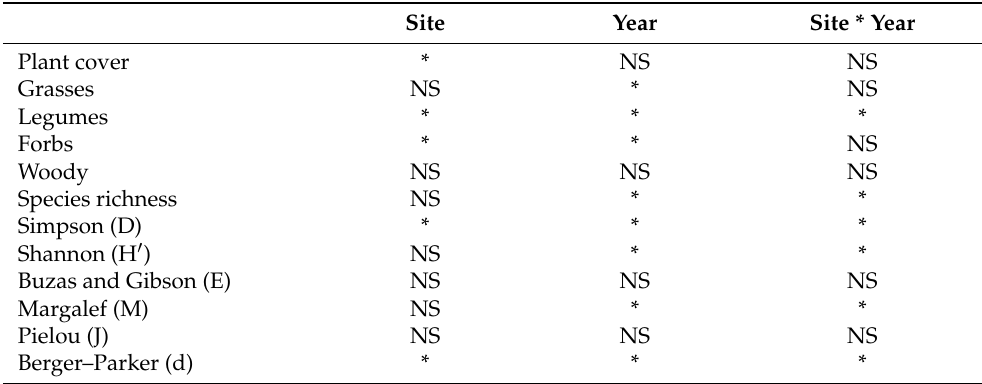
Table 2. Statistical significance of F ratios from the analysis of variance for plant cover, functional group composition, and diversity indices.